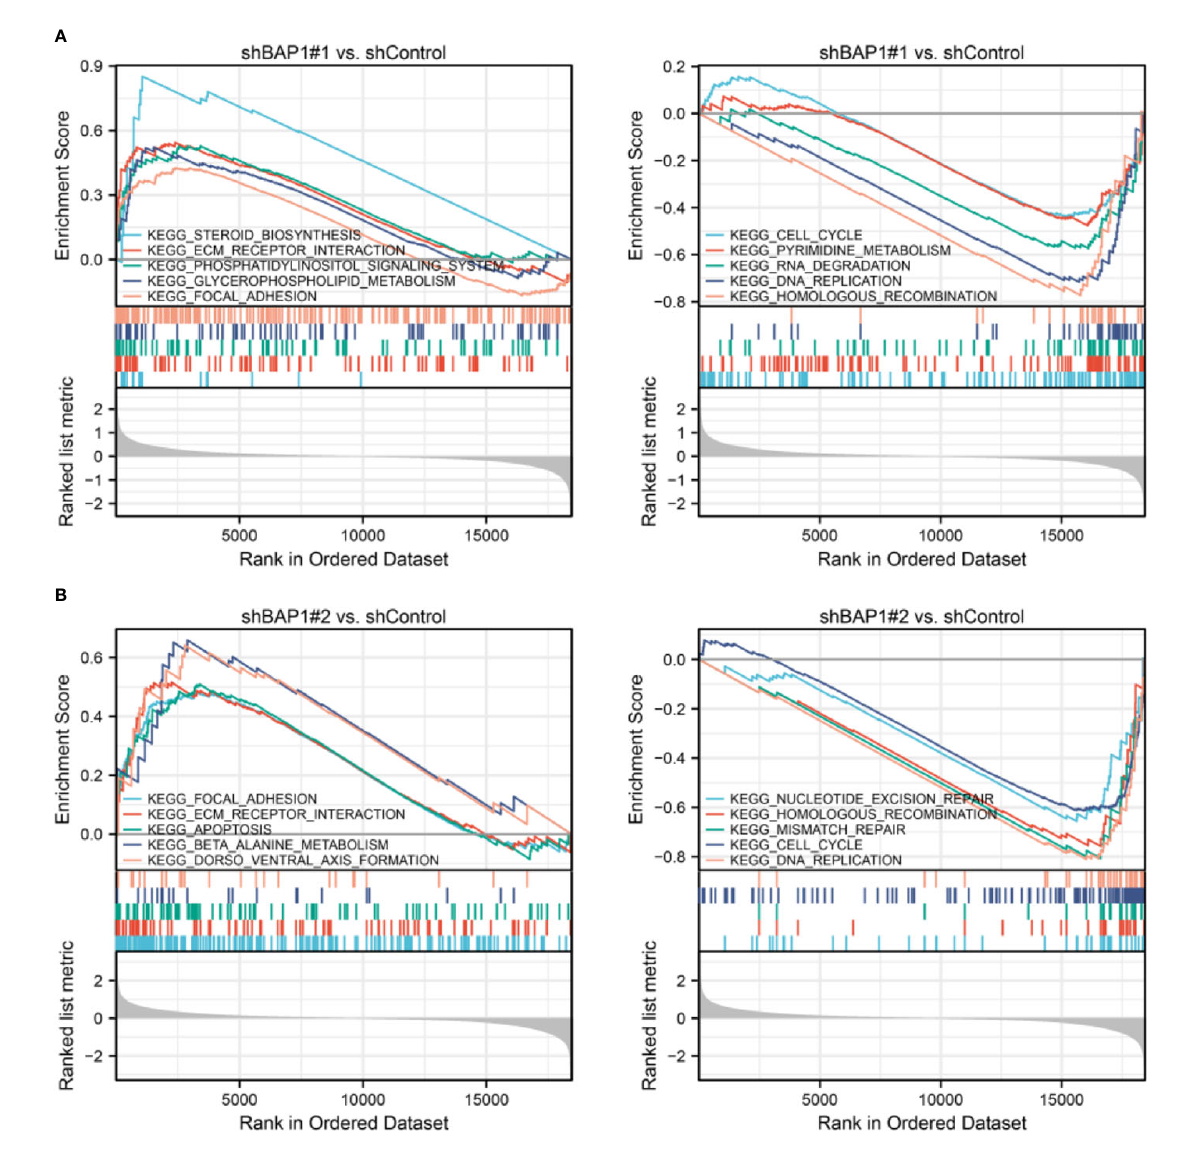
FIGURE 5 GSEA analysis in KEGG gene sets. (A) Top 5 KEGG terms with largest |NES| enriched in shBAP1#1 samples. (B) Top 5 KEGG terms with largest | NES| enriched in shBAP1#2